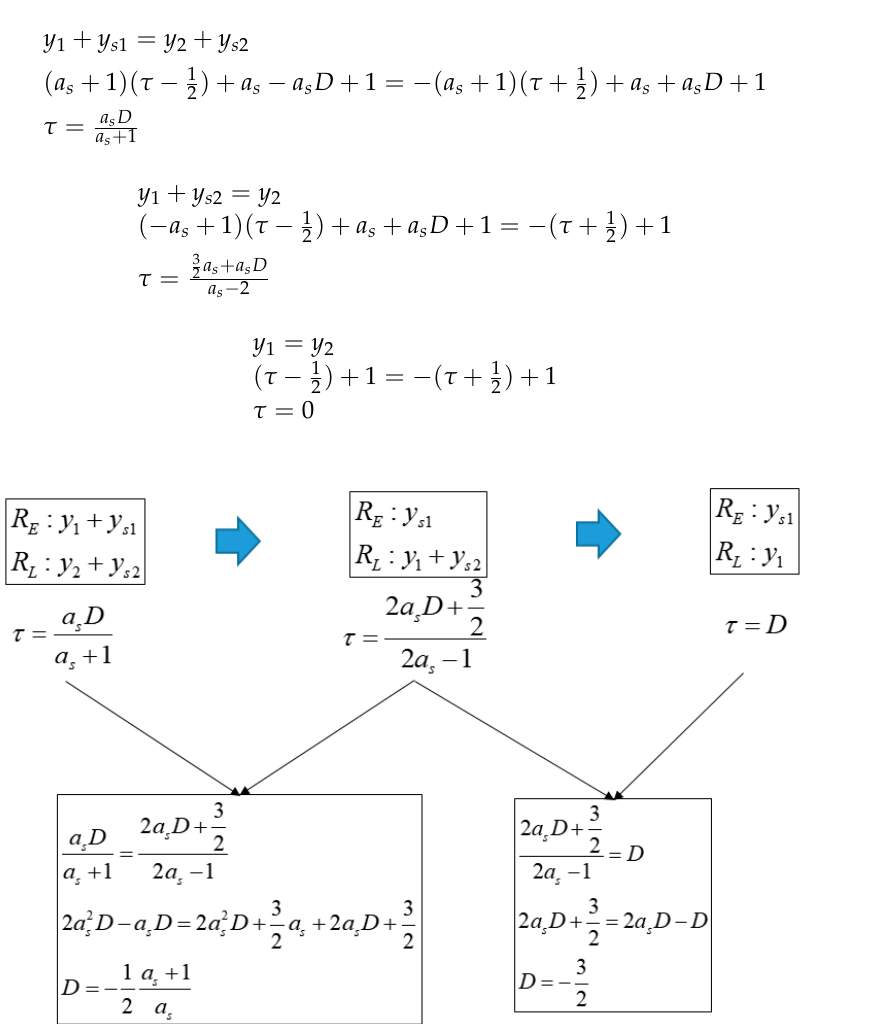
Figure 9. Equation of τ and D in case that the spoofing signal strength is larger than authentic signal and XE is same with XL .